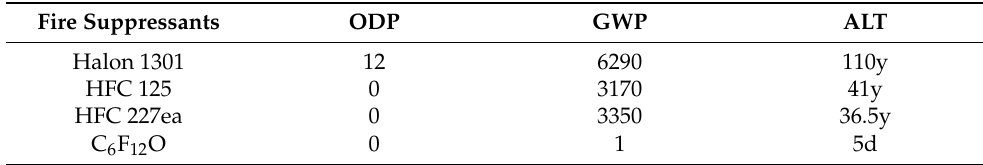
Table 1. Environmental characteristics of four typical fire suppressants (Halon 1301, HFC 125, HFC 227ea and C 6 F 12 O) [7]. Fire Suppressants ODP